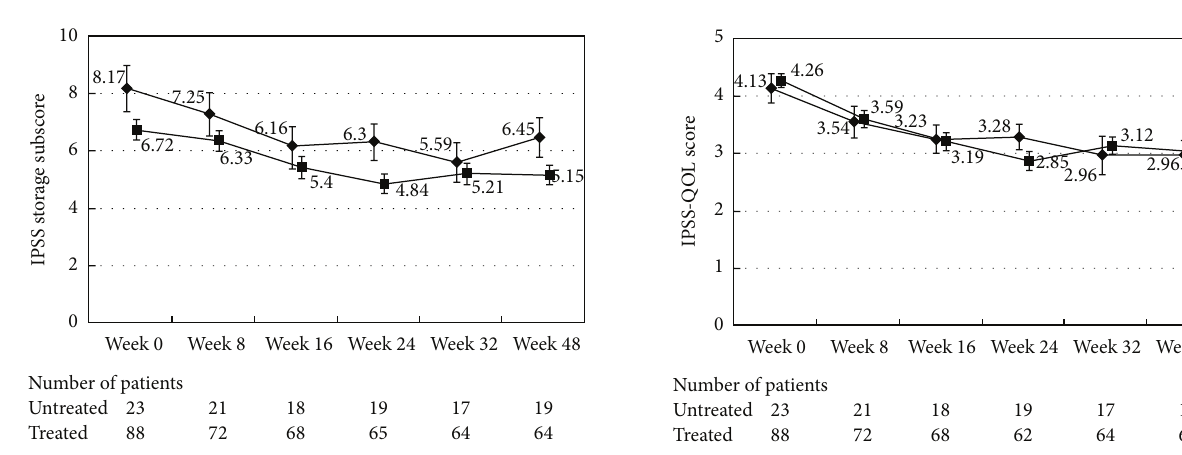
Figure 3: International Prostate Symptom Score storage subscore (total scores of questions 2, 4, and 7). The scores in the patients treated with an 𝛼 1-blocker or anticholinergic agent ( ◼ ) and the untreated patients ( ⧫ ) are shown. The values are LS mean ± SE. 𝑃 = 0.0887 (repeated ANOVA).